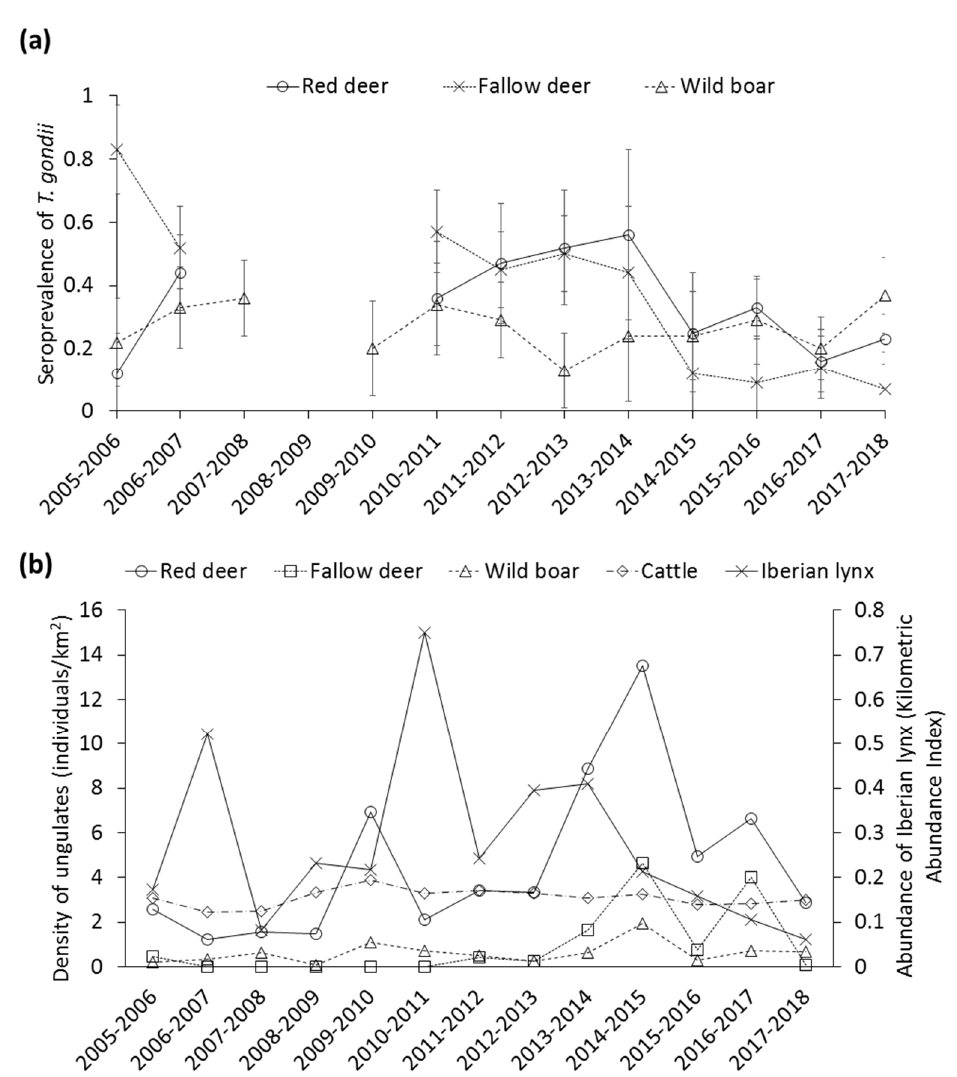
Figure 3. Temporal trend of the ( a ) seroprevalence of Toxoplasma gondii (± CI 95%), and ( b ) population density of red deer, fallow deer, wild boar, and cattle (individuals / km 2 ), and Kilometric Abundance density of red deer, fallow deer, wild boar, and cattle (individuals/km 2 ), and Kilometric Abundance Index of Iberian Index of Iberian lynx.